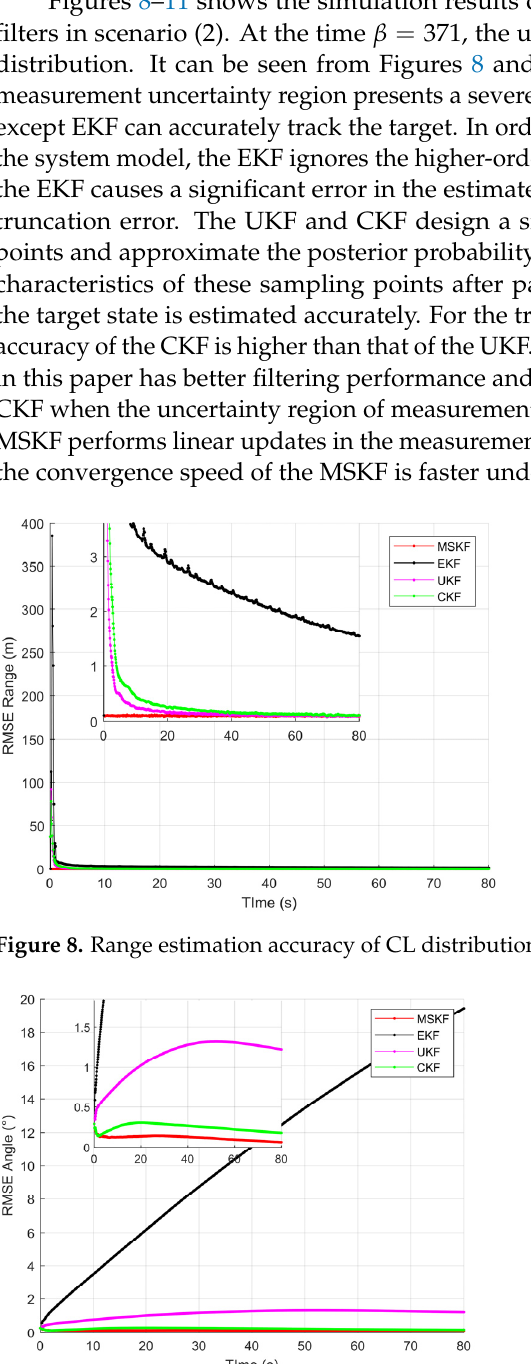
Table 2. Different filtering accuracy and time consumption in scenario (2).